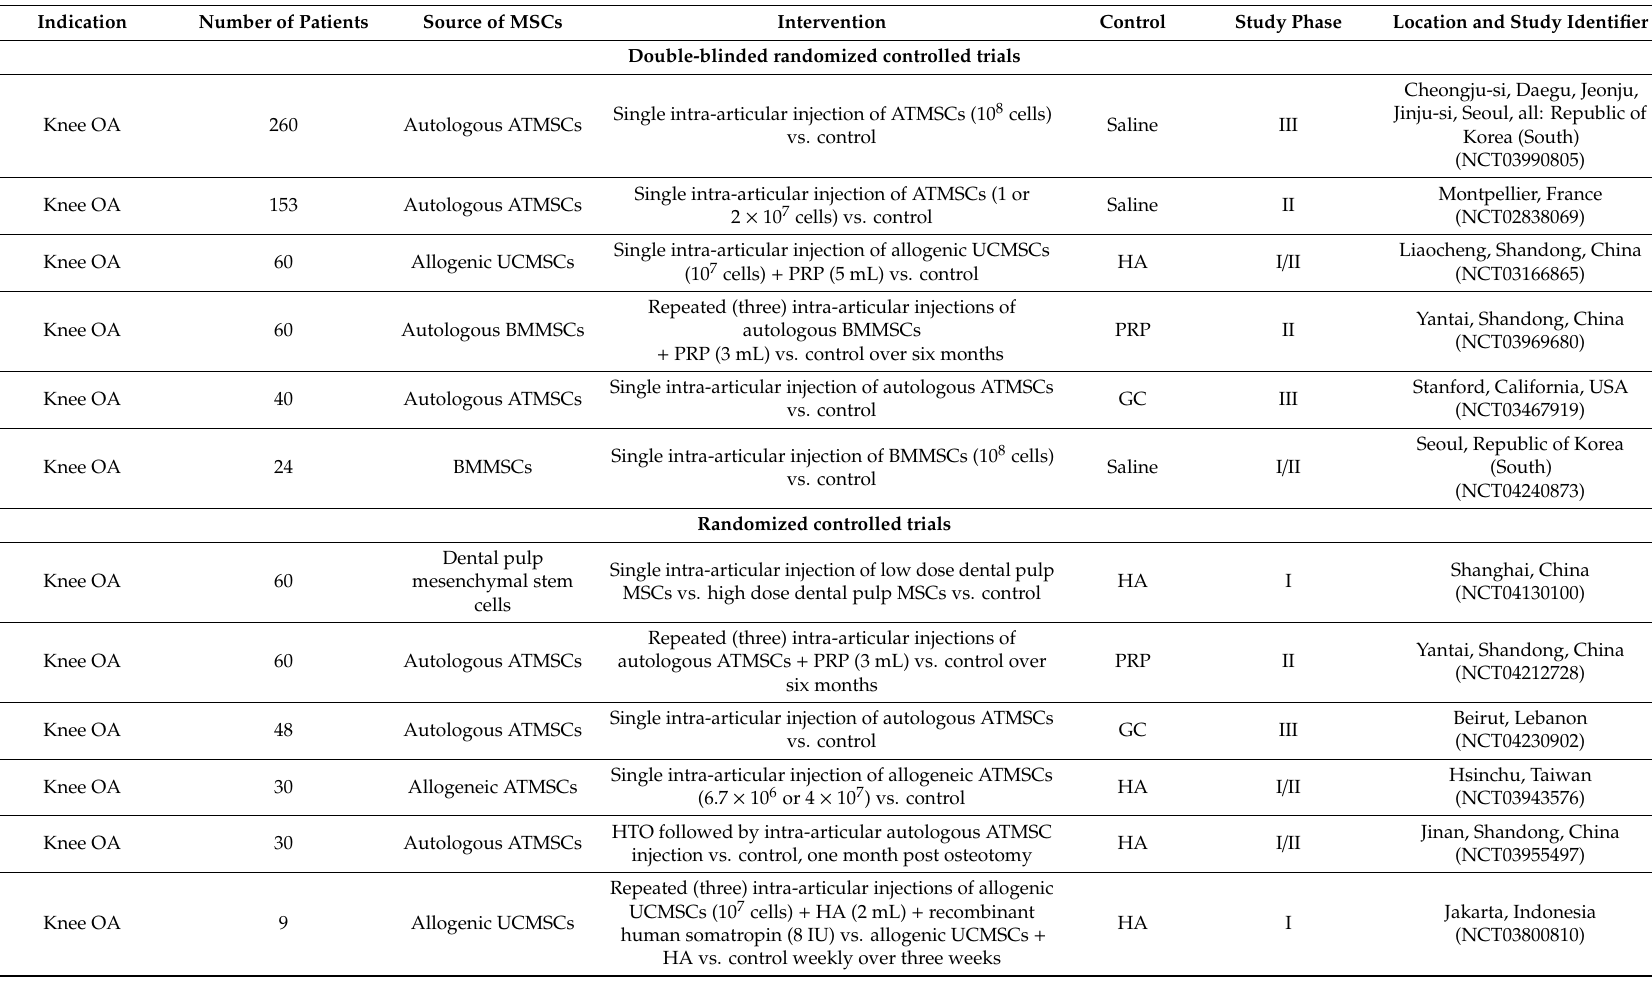
Table 1. Studies “currently recruiting” patients for MSC-based therapies for OA, listed on clinicaltrials.gov, categorized by study design and sorted by number of